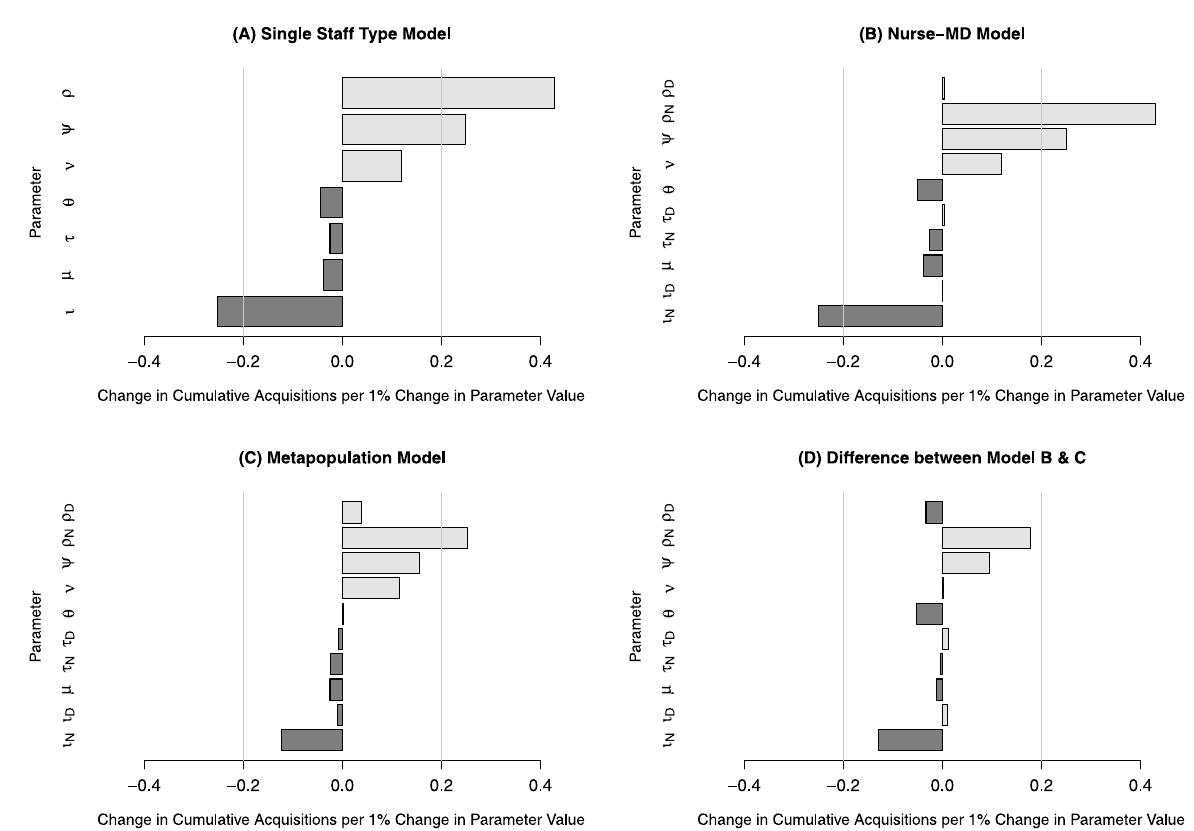
Fig 3. Global parameter sensitivity of three modeled ICU population structures. Panel A depicts the change in proportional change in cumulative MRSA acquisitions per one-percent change in the value of a specific parameter, with light bars indicating increased acquisitions, and dark bars indicating decreased acquisitions for a model assuming random mixing and with a single staff type for both nurses and physicians. Pale grey vertical lines indicate a change greater than 0.2 in either direction, which was used as a boundary condition for major changes. Panel B depicts the same for a model that separates nurses and physicians into different staff types, while Panel C depicts the same for a metapopulation model where nurses were assigned to a strict subpopulation of patients. Panel D depicts the difference in proportional changes between the Metapopulation and Nurse-MD